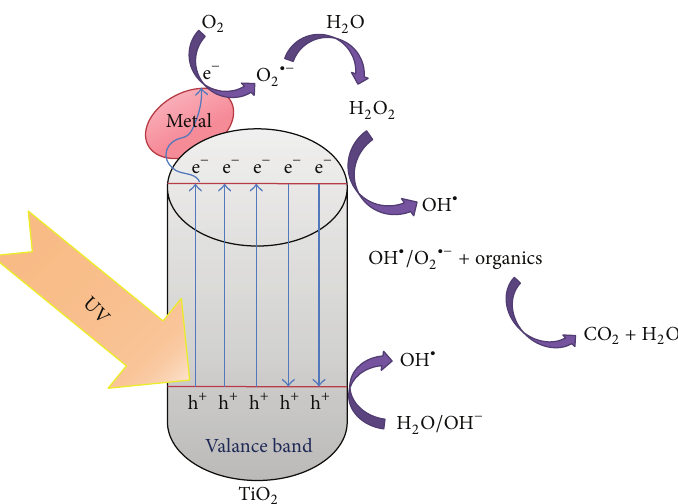
Figure 4: The mechanism of photodegradation of organic pollutants over metal/TiO 2 in water under UV light irradiation.